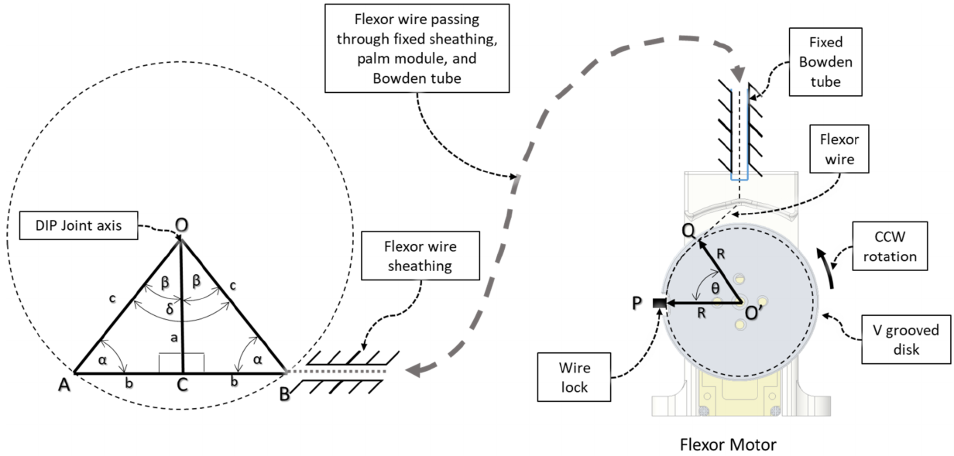
Figure 12. Relation between DIP flexion angle (left) and flexor motor’s angular rotation (right). Knowing β allowed us to find α , as ∠ OCA = ∠ OCB = 90 ◦ , and then we calculated the radius of the constructed circle, OA , for the DIP extended configuration, using Equation (2) and cord length, and ACB using Equation (3):